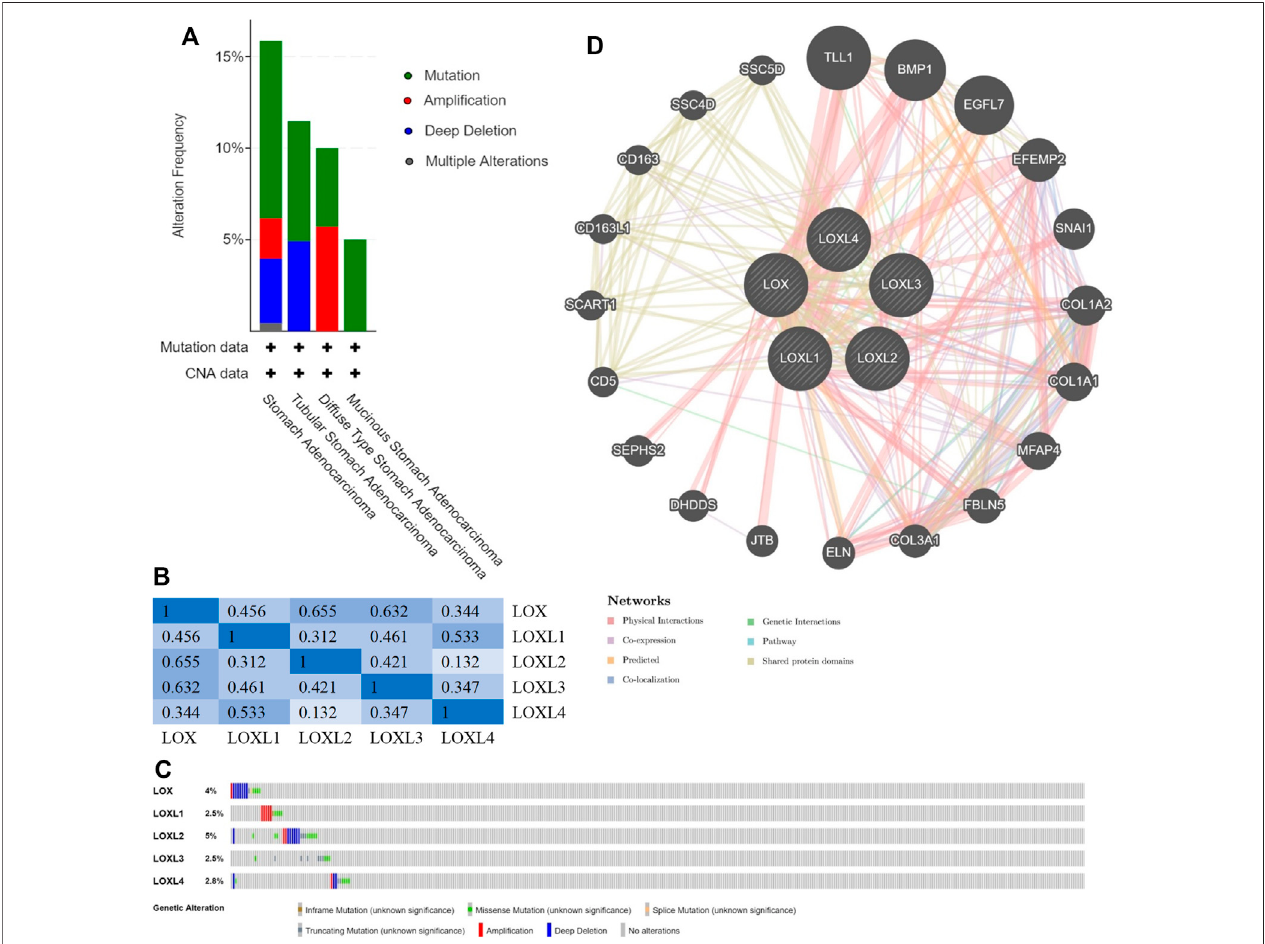
FIGURE5| Genomic alterations (cBioPortal)and network(GeneMANIA) ofLOXfamilyinGC. (A) DistributionofLOXfamilygenomicalterations accordingtocancer type. (B) CorrelationsofdifferentLOX family memberswith each other inGC. (C) OncoPrint ofLOX family alterations inGC. (D) Network ofthe 20most frequently altered neighboring genes of LOX